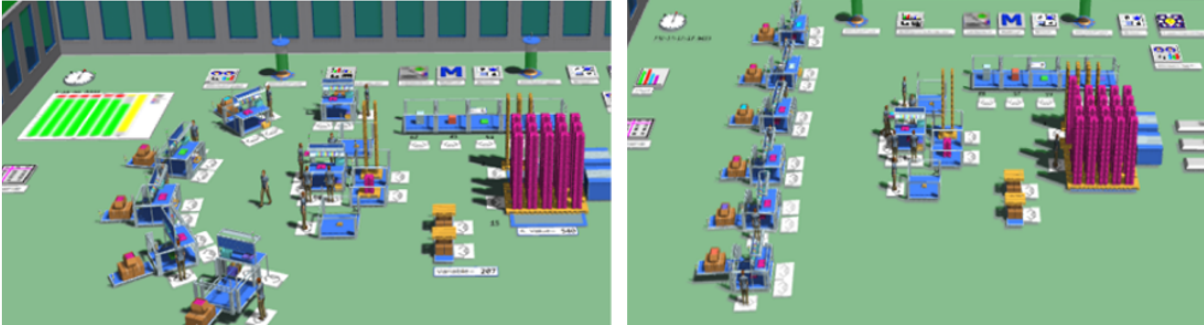
Figure 6. Tecnomatix 3D model for both layouts: curved (left), linear